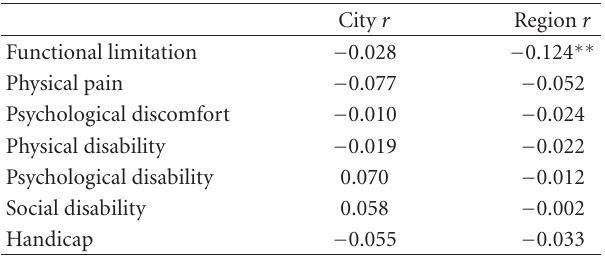
Table 4: Significance of the OHIP-14 subscales according to city and